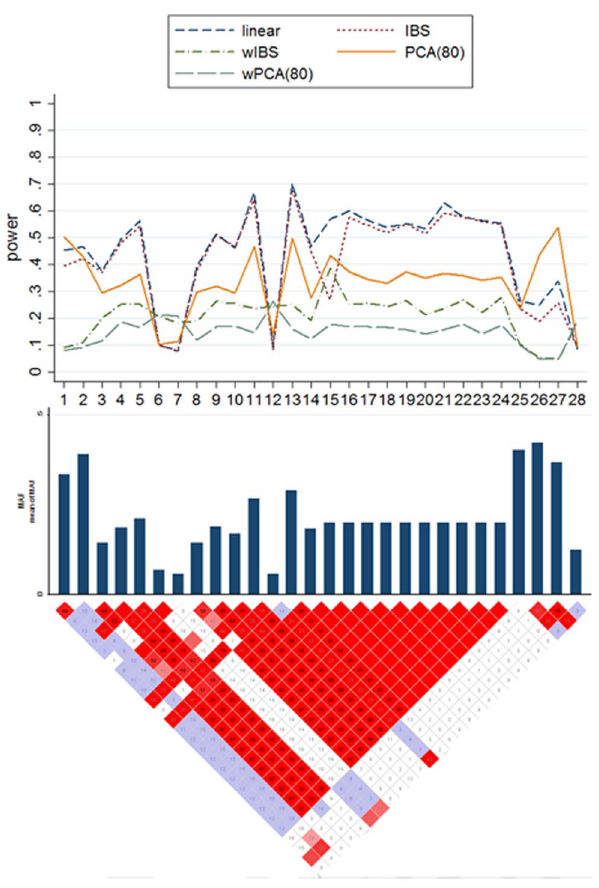
Figure 4. Test of Power for LKM, PCA and wPCA in Scenarios B2. The top plot shows the power (y-axis) of each method over the locations (x-axis) of the causal SNPs. The bar-plot shows the MAFs of all SNPs. The bottom plot shows the LD structure of the 28 SNPs downloaded from the HapMap project, in which the red scale indicates the value of r 2 (1=red, 0=white).